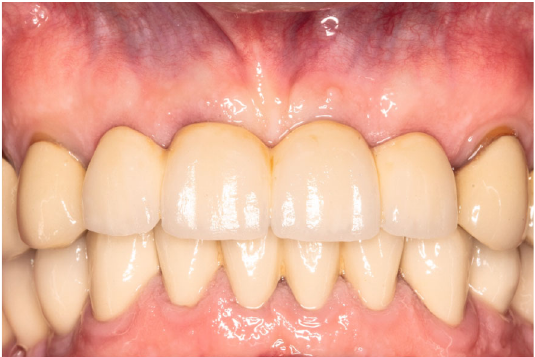
Figure 7: Three-month follow-up, after implant placement.